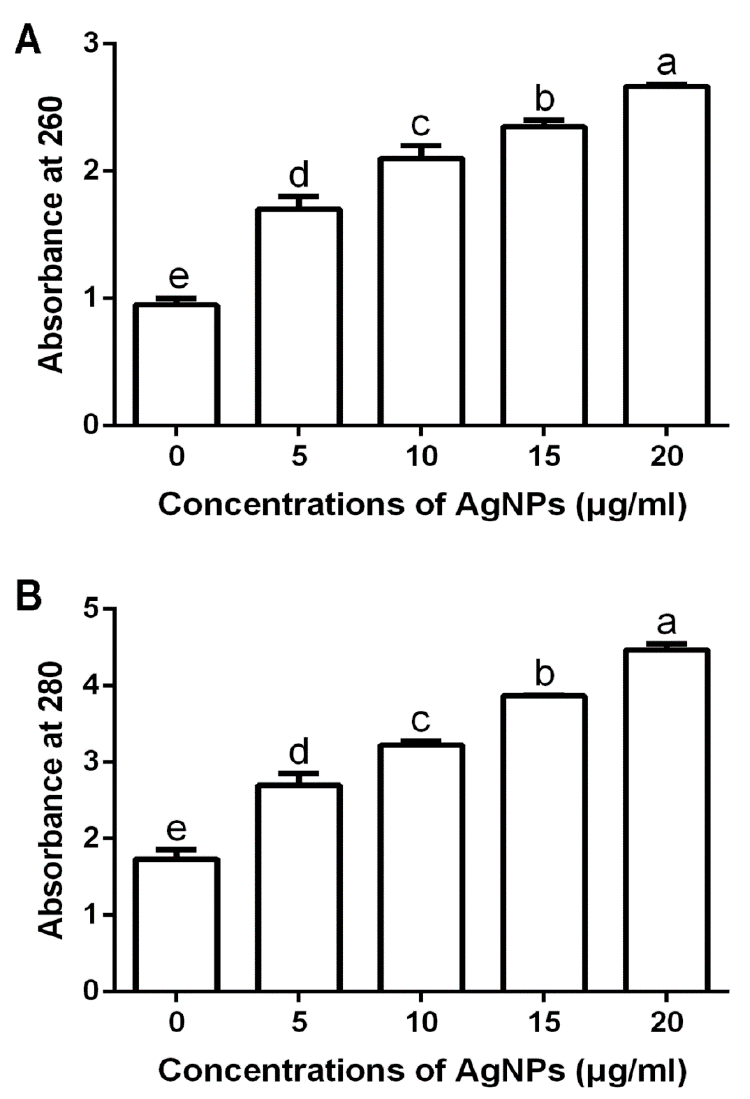
Figure 4. Biosynthesized AgNPs at di ff erent concentrations caused the leakage of DNA ( A ) and proteins ( B ) from F. graminearum strain PH − 1 spore cells. Data are a mean value ± standard error of three replicates, and bars with the same letters are significantly di ff erent in LSD test ( p < 0.05).